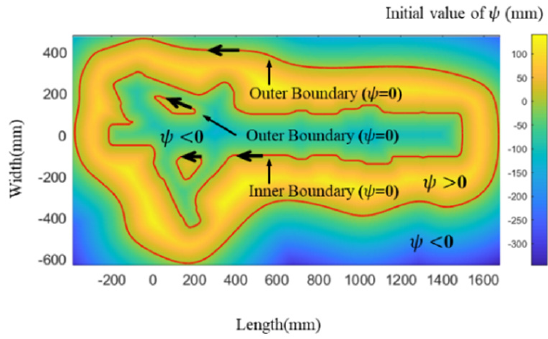
Figure 3. Initial value distribution of the level set function ψ .